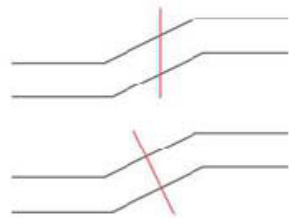
Fig. 4: Orientation of the section plane